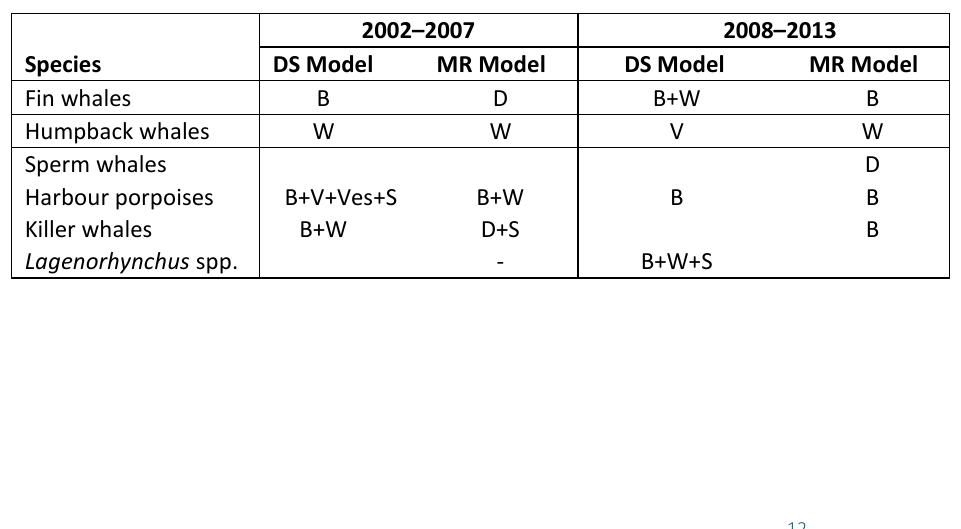
Table 5. Covariates included in the final models for each species in the 2002 – 2007 and 2008 – 2013 surveys for the Distance Sampling model (DS model) and the Mark Recapture model (MR model). Distance (D) is automatically added as a covariate in the DS Model. B=Beaufort, W=weather, Ves=vessel, V=visibility, G=glare, S=group size,